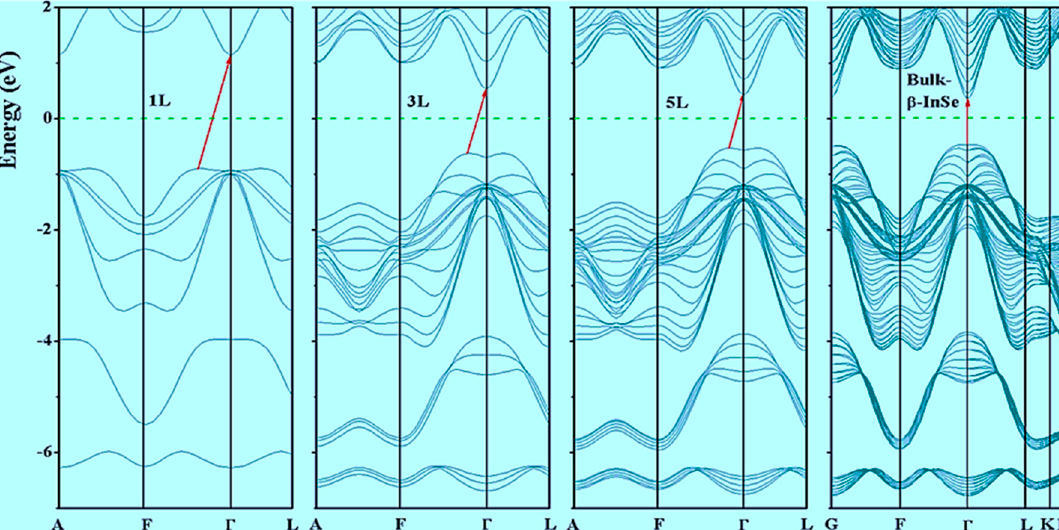
Figure 2. Electronic band structures of β -InSe monolayer (1 L), few-layer (3 L and 5 L) and bulk β -InSe, extracted from HSE06 functional calculations. The green dashed line is Fermi energy level set to 0.0 eV.